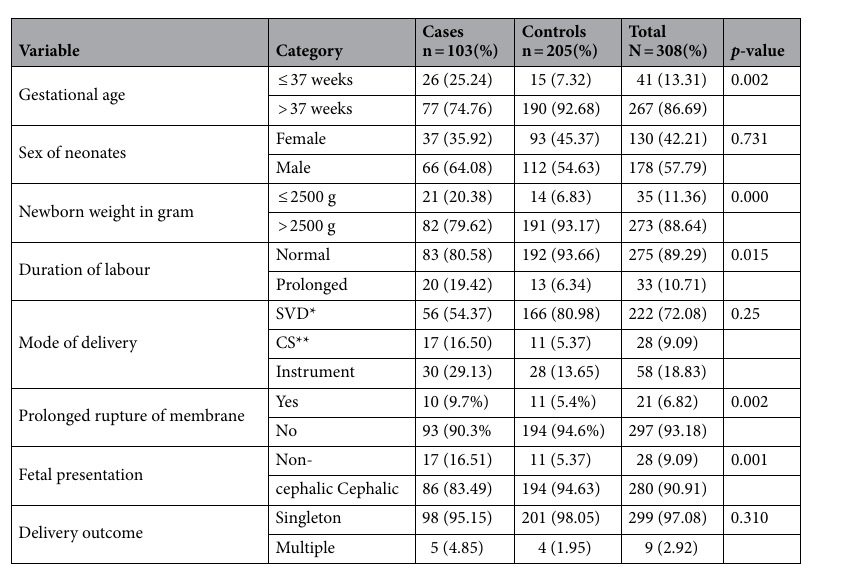
Table 3. Neonatal and Intra-partum characteristics of mothers who delivered at Ilu Aba Bor, in Public Hospitals, Ethiopia, 2021. *SVD, Spontaneous vaginal delivery; **CS, Cesarean Section.